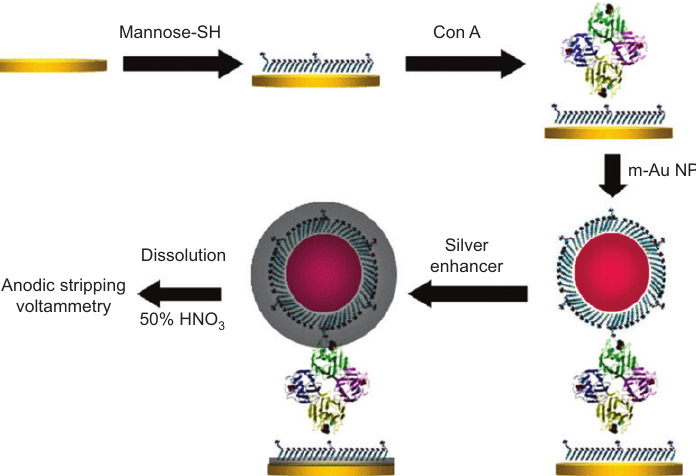
Figure 15 Schematic illustration of the electrochemical lectin biosensor based on mannose-stabilized AuNPs and Ag enhancement. From Ref. [116]